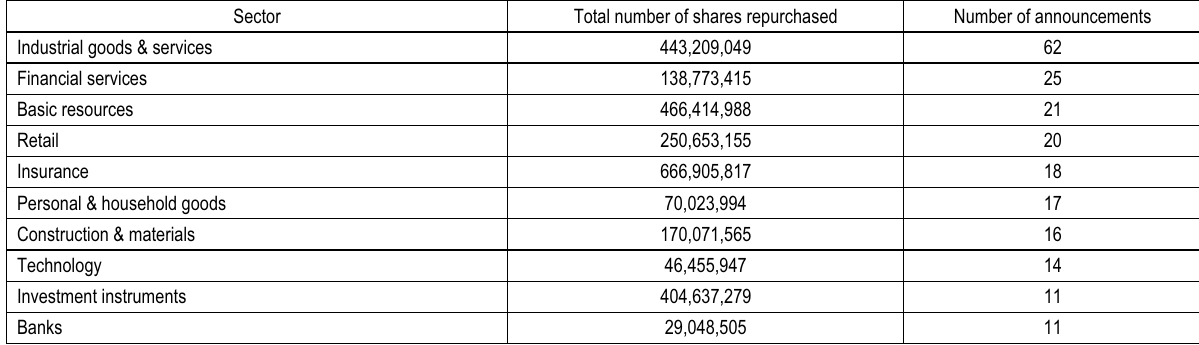
Table 3. Distribution of JSE sectors that repurchased shares